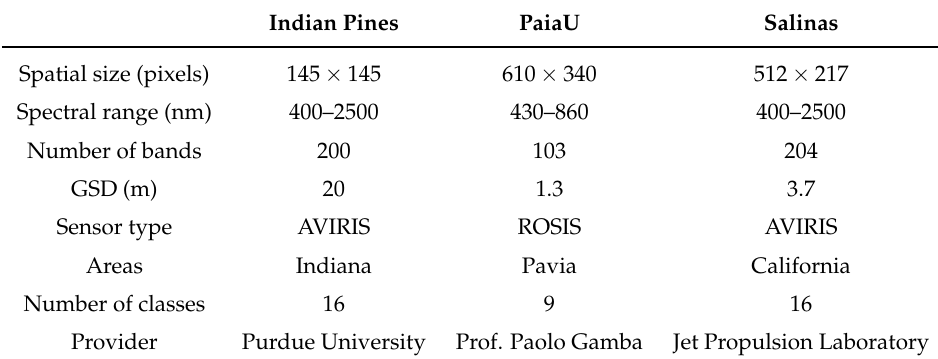
Table 1. Details of the Three Data Sets: Indian Pines, PaviaU, and Salinas.